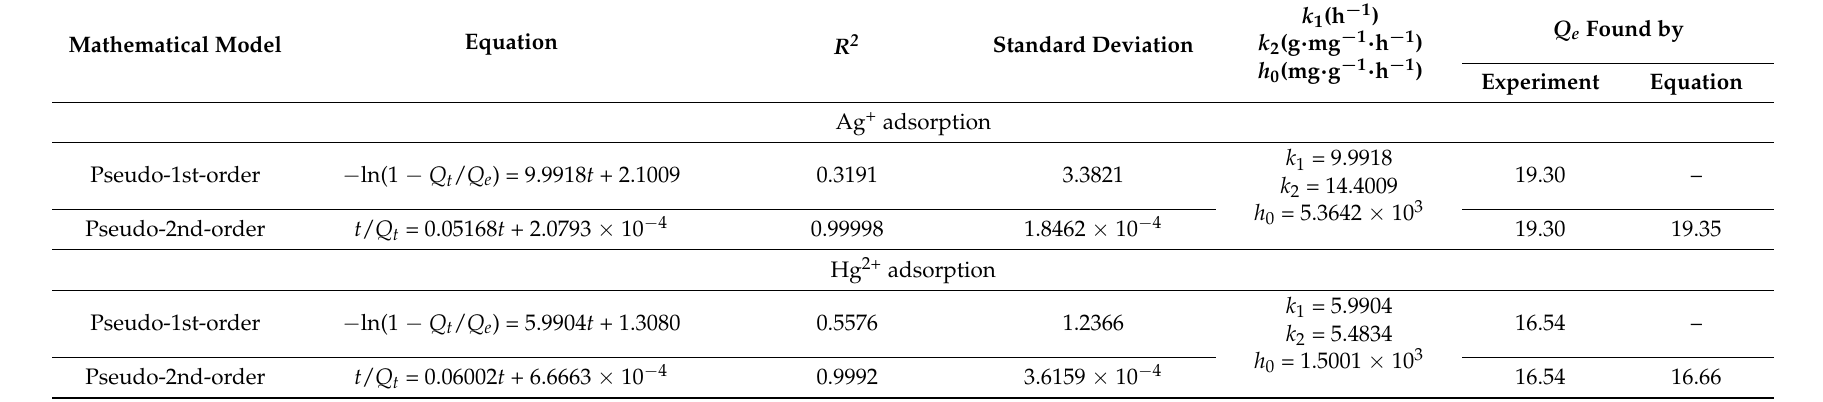
Table 3. Kinetic model equations for Ag + and Hg 2+ adsorption on PTT